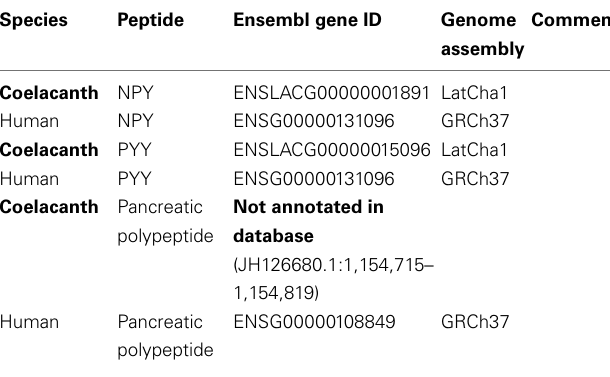
Table 2 |The table lists Ensemble gene ID for the coelacanth and human NPY-family peptides NPY, PYY, and PP (pancreatic